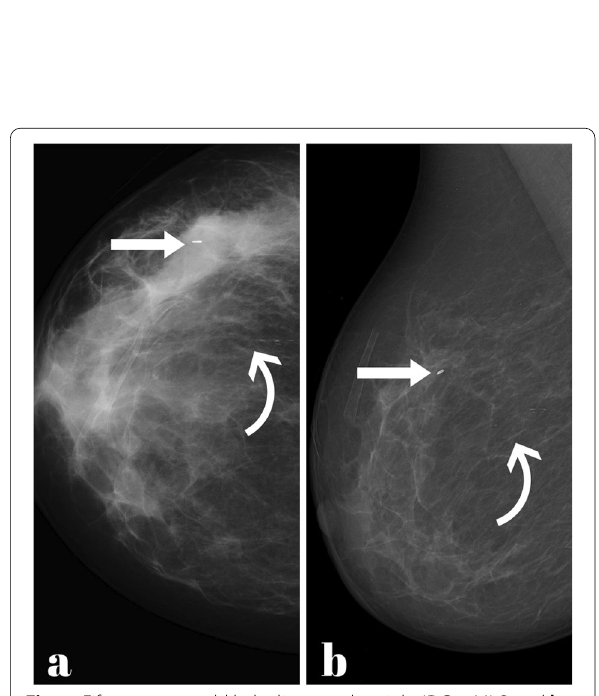
Fig. 4 Fifty‑two years old lady diagnosed as right IDC. a MLO and b CC views show a central clip [straight arrow] within the speculated right upper outer breast mass. Linear calcifications are seen [curved arrow]